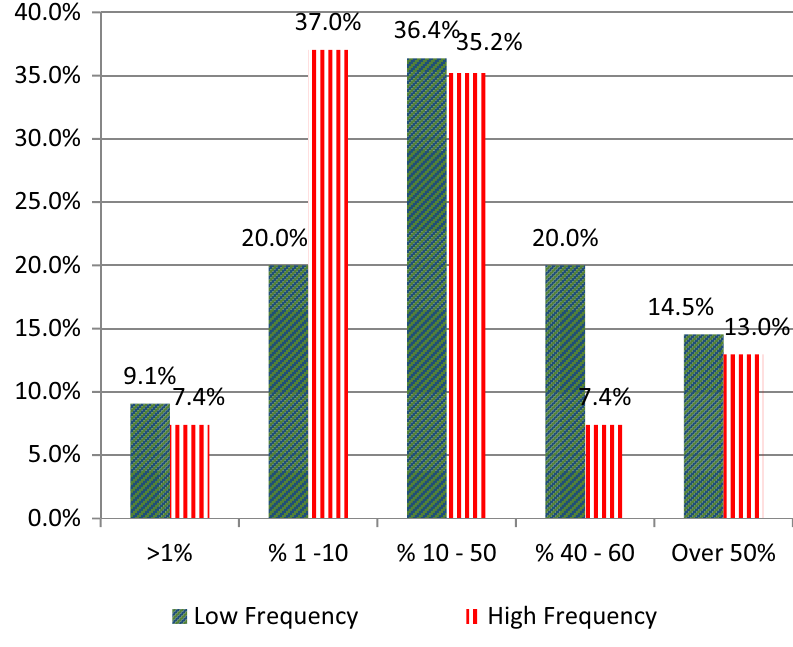
Fig. 2 Perceived risk of being apprehended by the police while committing a traffic violation on an interurban road in relation to the frequency of speeding